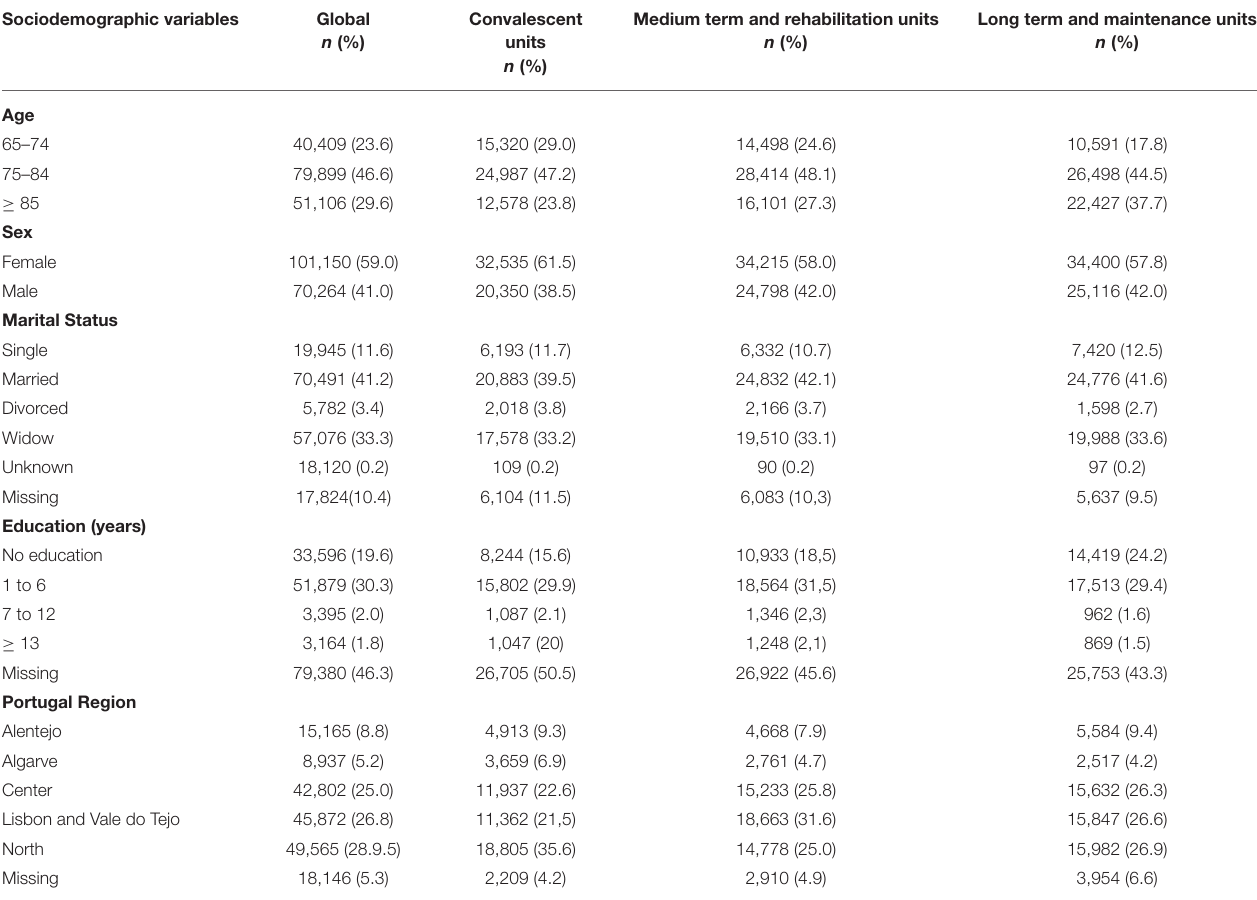
TABLE 1 | Sociodemographic characterization of the sample ( N = 171,414). Sociodemographic